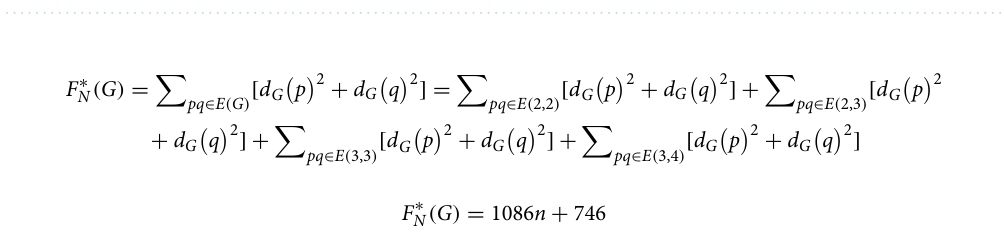
Table 2. Edge partition of ZNSL in relation to the